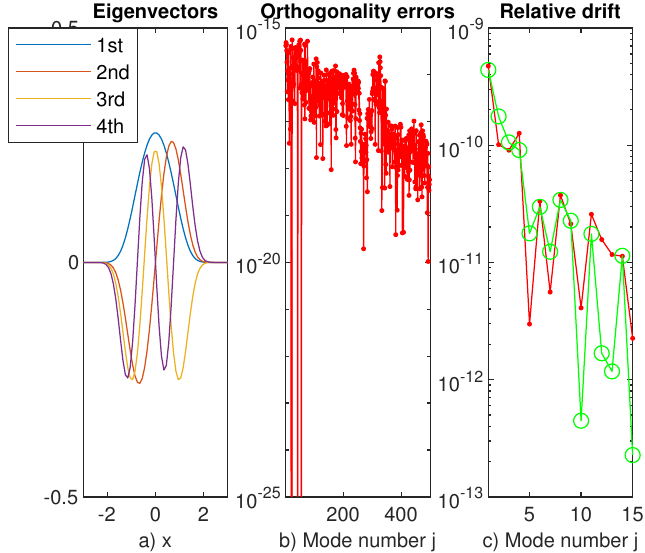
Figure 14. ( a ) The first four eigenvectors of problem (13) computed with N : = 500 and scaling factor h : = 0.1; ( b ) the orthogonality errors (deficiency) of the first eigenvector of the same problem with respect to the subsequent 499 of it; ( c ) the relative drift of the first 15 eigenvalues of problem (13) N 1 : = 500 and N 2 : = 400-red dotted line and N 1 : = 300 and N 2 : = 400-green